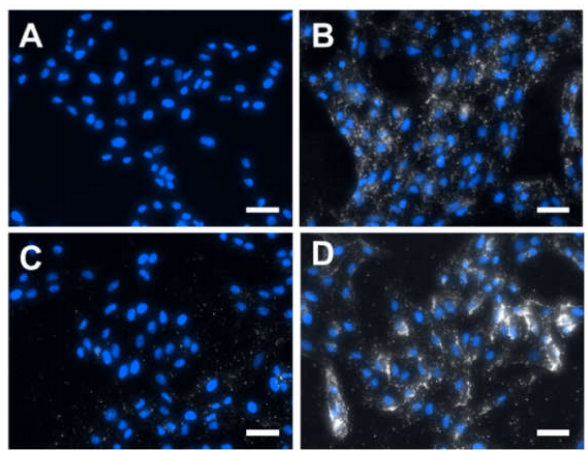
Figure 4. Dark-field microscopy images of the cellular internalization of AuNPrs. Cell nuclei were stained with 4 (cid:48) ,6-diamidino-2-phenylindole (DAPI). ( A ) Vero cells as negative control, and treated with ( B ) 1100NPr-PEG, ( C ) 1100NPr-GSH-PEG, and ( D ) 1100NPr-GSH-PEG functionalized with a Gly-Arg-Gly-Asp-Ser (RGD) sequence (1100NPr-GSH-PEG-RGD). Concentration 50 µ g / mL was used for all the NPrs. Scale bars correspond to 50 µ